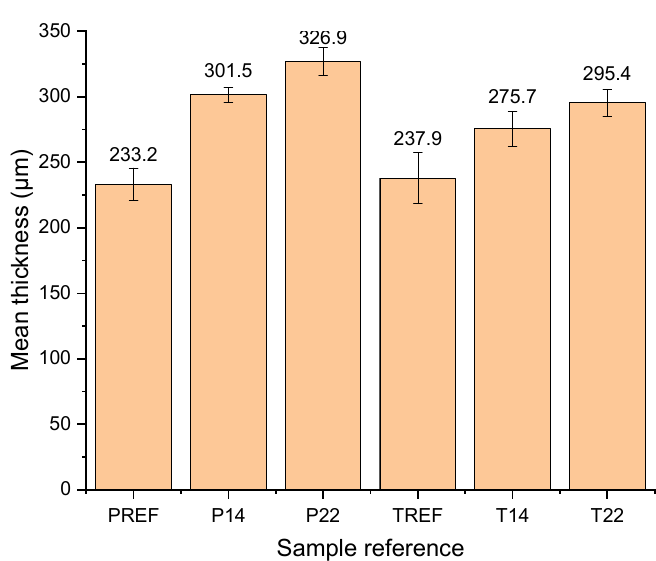
Figure 12. Mean thickness ( µ m) of the textile fabrics before 3D printing (PREF and TREF) and the 3D- PPOT materials after 3D printing (P14, P22, T14 and T22). PREF and TREF stands for plain fabric